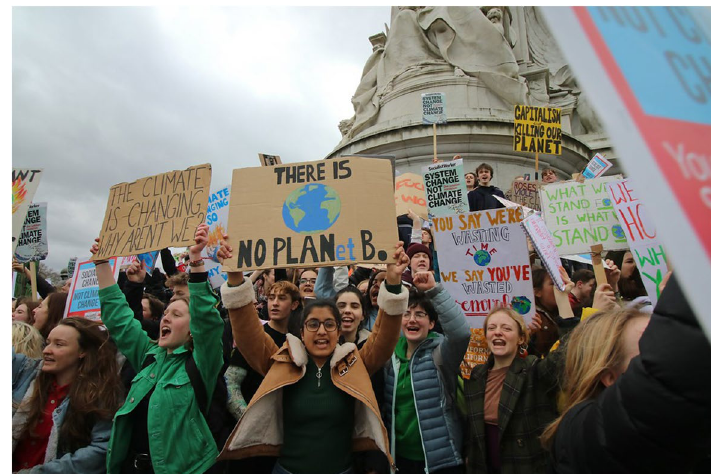
Fig. 3 Second Youth Strike for Climate Justice, London 15th March 2019. Photo: Steve Eason. Licensed under the CreativeCommons Attribution-Share Alike 2.0 Generic